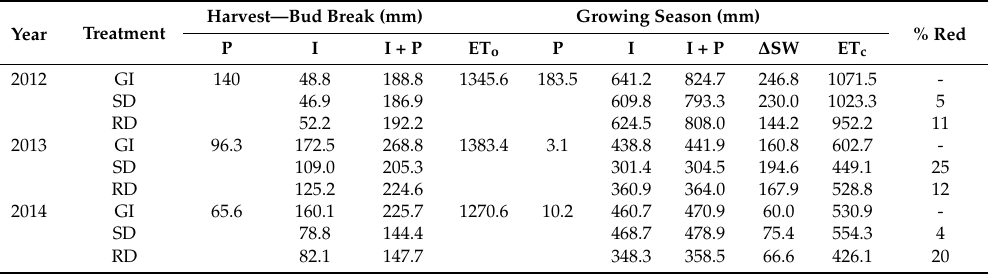
Table 2. Crop reference evapotranspiration (ET o ) based on California Irrigation Management Information System (CIMIS) and local data, precipitation (P) and applied water (I) and change in soil water content ( ∆ SW) data from harvest the previous year to bud break the current year and the growing season bud break to harvest in the current year and percentage of reduction (Red) in applied water compared to grower practice (GI) at Fiesta raisin project in Caruthers, CA. Grower Irrigation (GI) weekly beginning at bud break until cane cutting, halt until harvest then resume weekly until end of October, Sustained deficit (SD)—sustained deficit equal to 80% of GI, and Regulated deficit (RD)—50% of GI until fruit set, increased to 80% of GI, decreased to 50% of GI after harvest. Crop water use (ET c ) is sum of rainfall and irrigation and change in soil